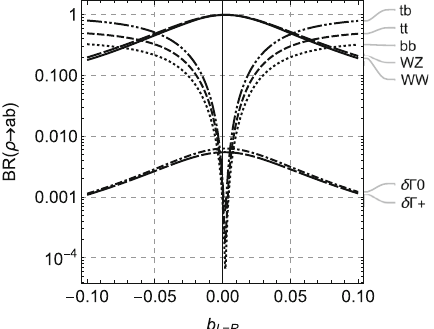
Fig. 3 The branching ratios of the neutral and charged vector reso- nances as functions of b L = R ≡ b L = b R when M ρ = 1 TeV, g (cid:2)(cid:2) = 18, and p = 0 . 75. The labels δΓ 0 and δΓ + indicate the branching ratios corresponding to the decay widths given in the Eqs. (23) and (24), respectively